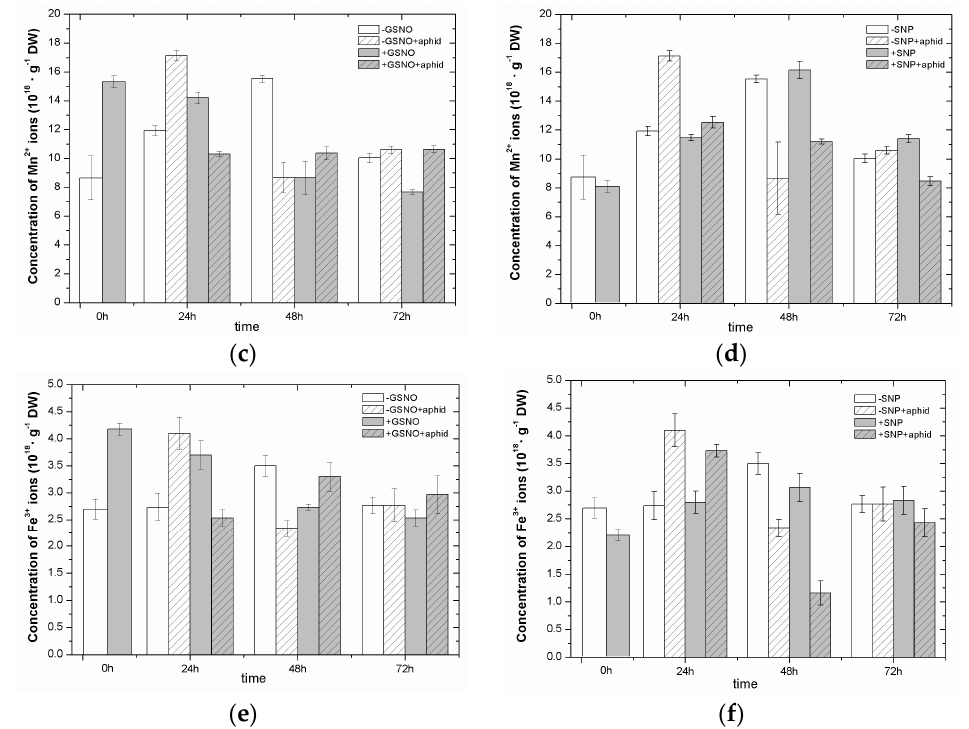
Figure 2. Effect of nitric oxide donors and A. pisum on concentrations of: semiquinone radical ( a , b ); manganese ( c , d ); and iron ions ( e , f ) in leaves of P. satium L. cv. Cysterski . The data were obtained in three independent experiments and statistically analysed using ANOVA ( p -values at α = 0.05). Hypotheses on the equality of means were verified by the two-sample t -test. To account for multiple testing, we used the Bonferroni correction (statistically significant differences are shown in Table S2).